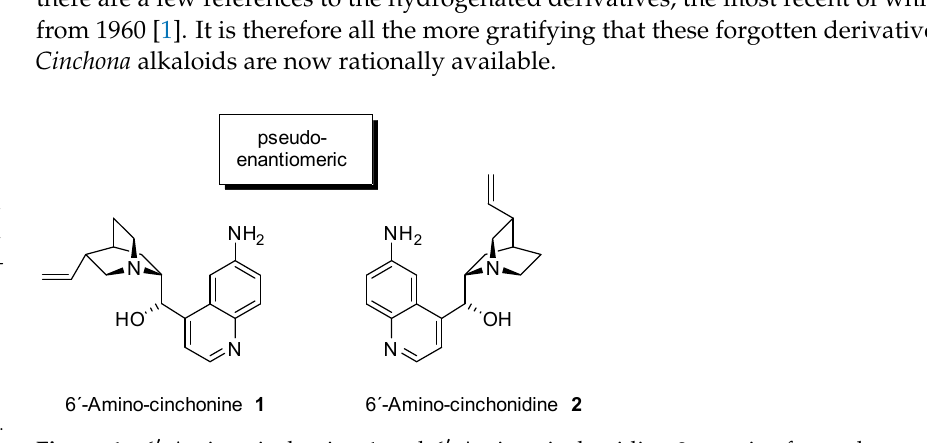
Figure 1. 6 (cid:48) -Amino-cinchonine 1 and 6 (cid:48) -Amino-cinchonidine 2 , a pair of pseudo-enantiomeric Figure 1. 6 ′ -Amino-cinchonine 1 and 6 ′ -Amino-cinchonidine 2 , a pair of pseudo-enantiomeric derivatives of the Cinchona alkaloids quinidine and quinine. derivatives of the Cinchona alkaloids quinidine and